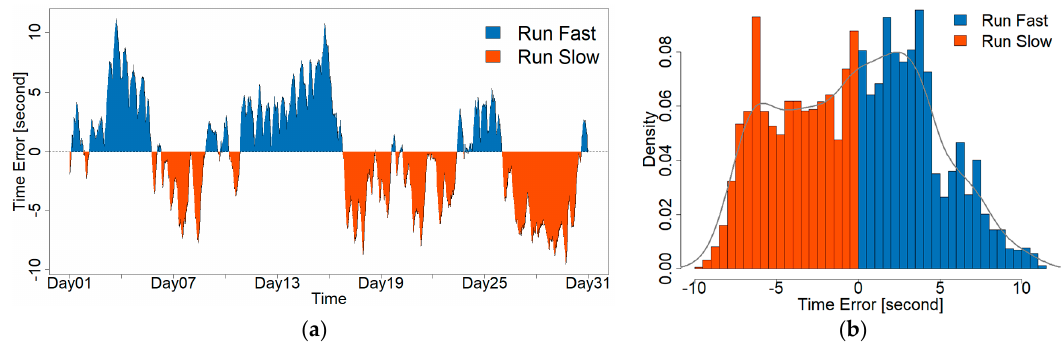
Figure 4. Time error change over one month in Western Electricity Coordinating Council (WECC) of North America. ( a ) Time-series curve of time error in October 2016; ( b ) Probabilistic distribution function of time error in one month. The blue color presents the fast time error. The orange color indicates the slow time error. The grey line shows the estimated probability density of time error.